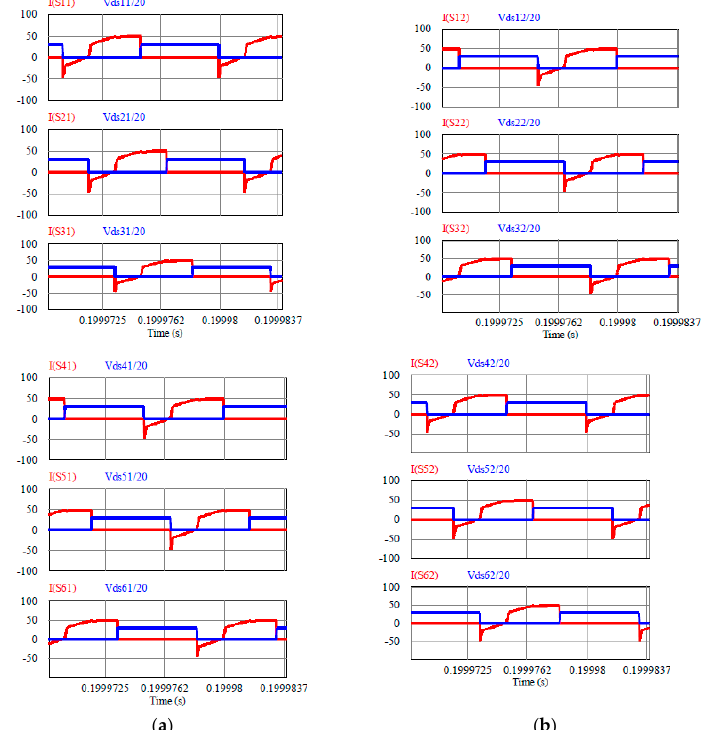
v v v i Lab , Lbc , Lca , and rect_in,a for ( c ) Module 1 and ( d )